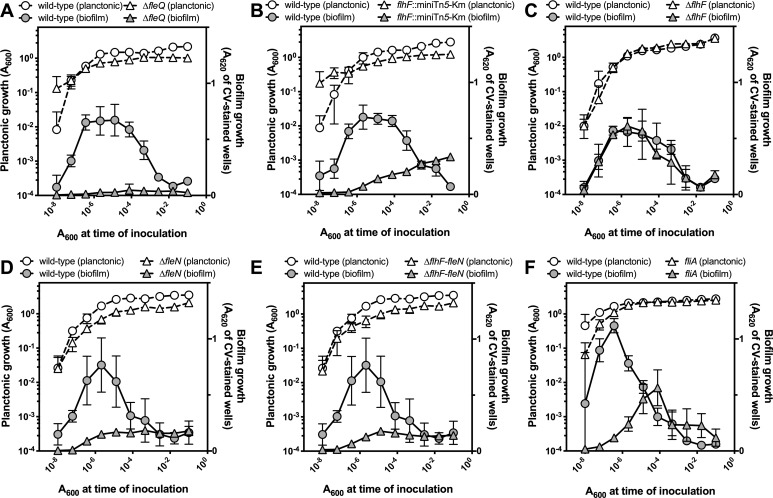
Serial dilution-based growth curves of flhF, fleN and fliA mutants.Planktonic (left axes, open symbols) or biofilm growth (right axes, closed symbols) is plotted against the initial A600 of each dilution. Circles represent the wild-type strain and squares represent the ΔfleQ mutant MRB52 (A), the flhF:miniTn5-km mutant MRB49 (B), the ΔflhF mutant MRB69 (C) the ΔfleN mutant MRB71 (D), the ΔflhF-fleN mutant MRB78 (E) or the fliA- mutant KT2440 fliA::aphA-3 (F). Plots display one representative experiment of at least three biological replicates. Error bars represent the standard deviation of the six technical replicates.